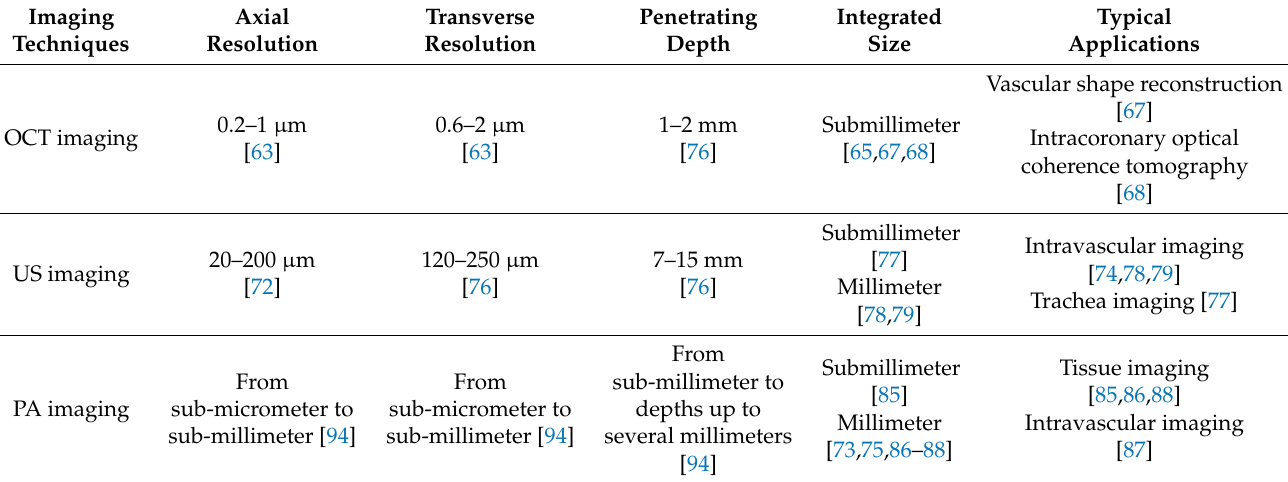
Table 1. Comparison between in vivo imaging